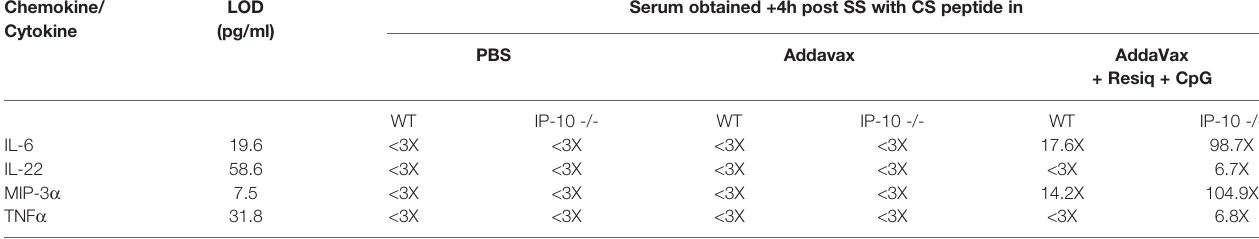
TABLE 2 | Chemokines/Cytokines in IP-10 -/- vs WT mice. Chemokine/ Cytokine